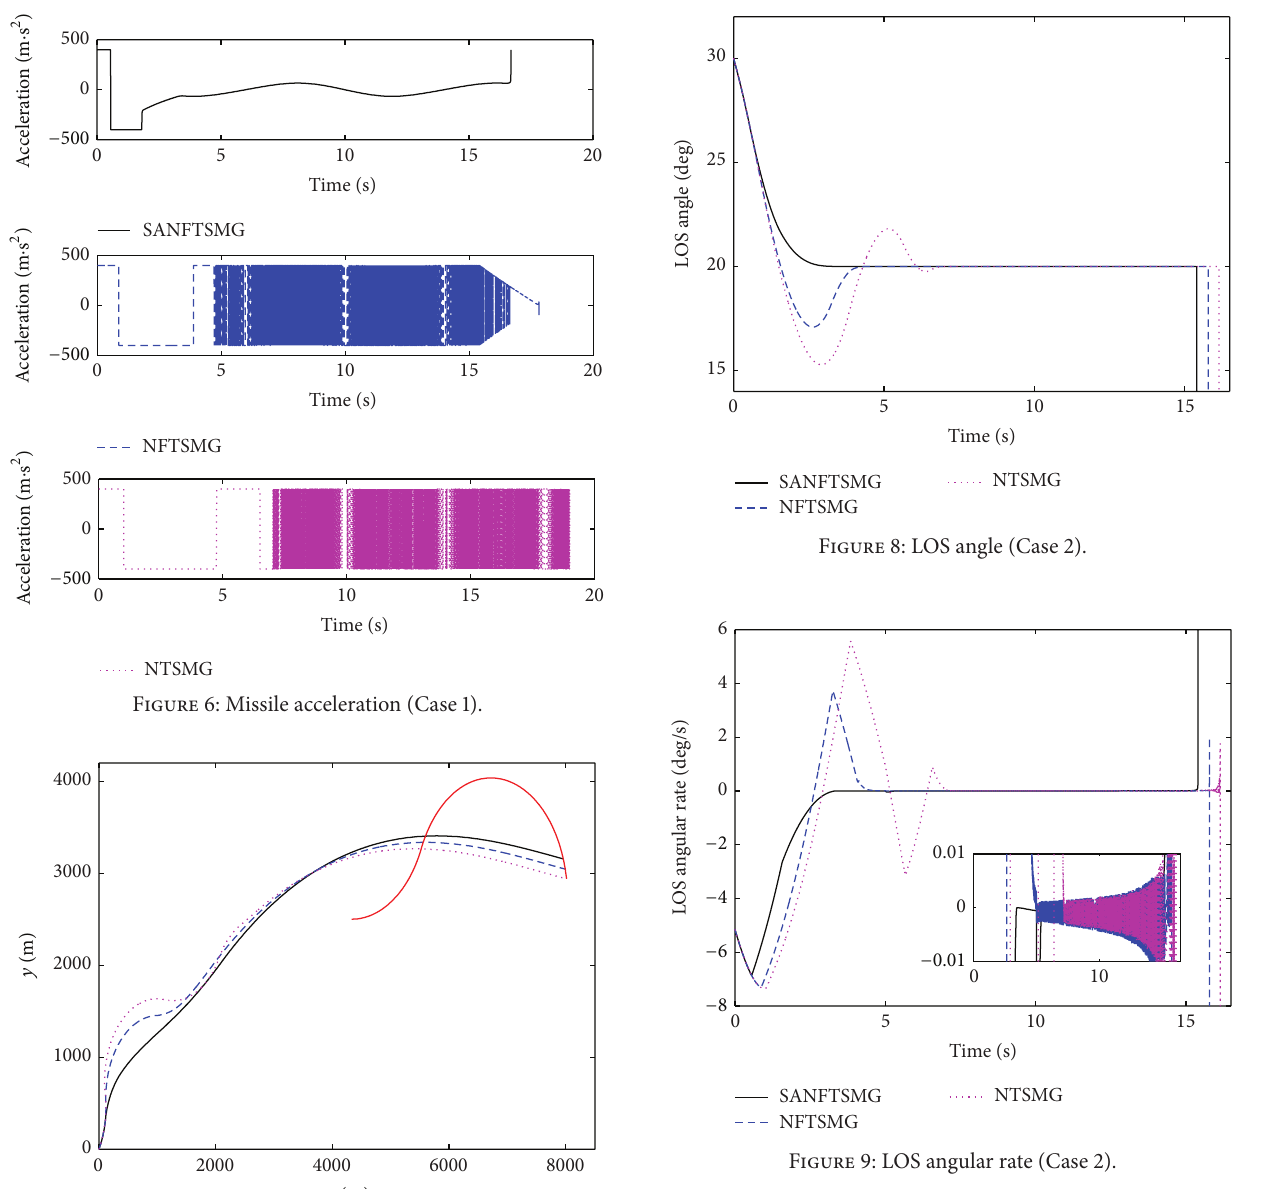
Figure 9: LOS angular rate (Case